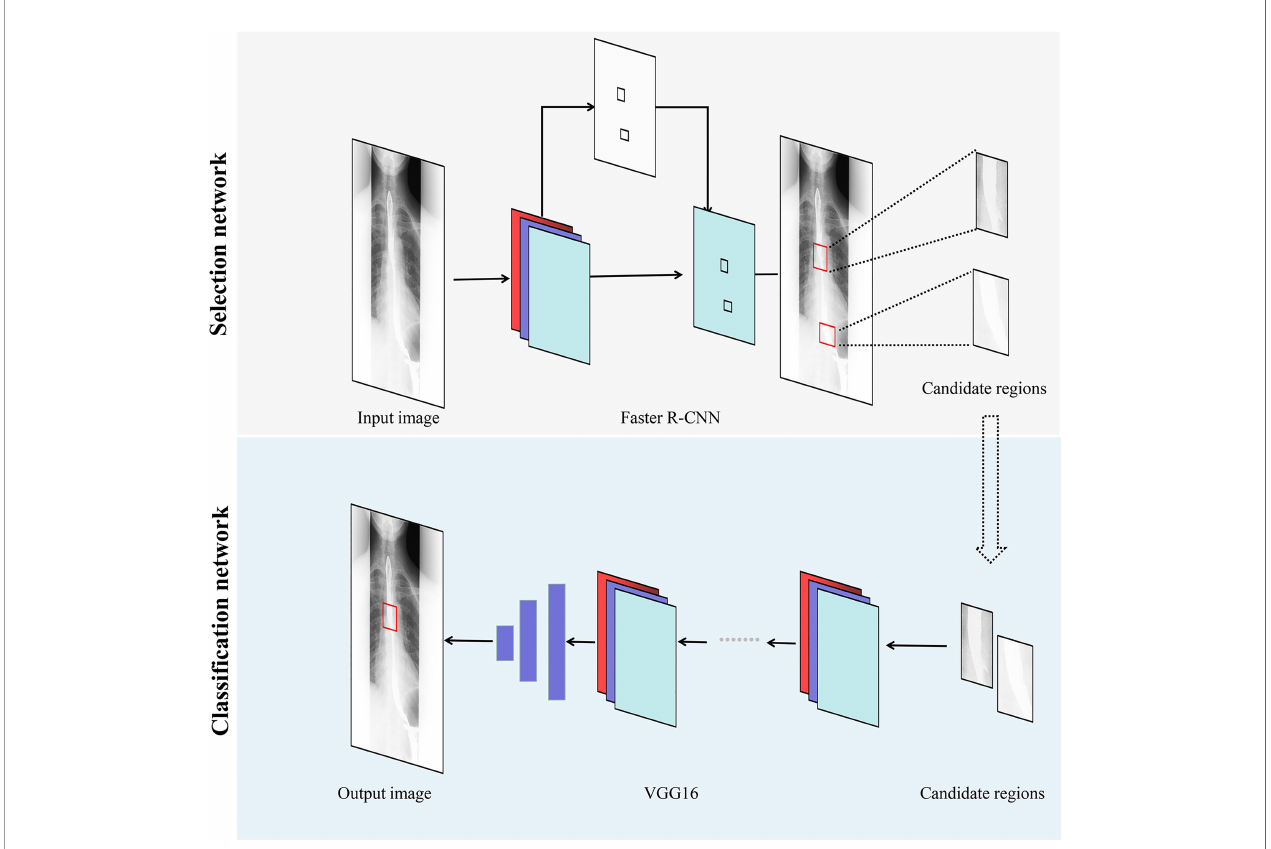
FIGURE 1 | Overview of our two-stage DLS for esophageal cancer detection. Faster R-CNN, faster region-based convolutional neural network; VGG, visual geometry group; DLS, deep learning